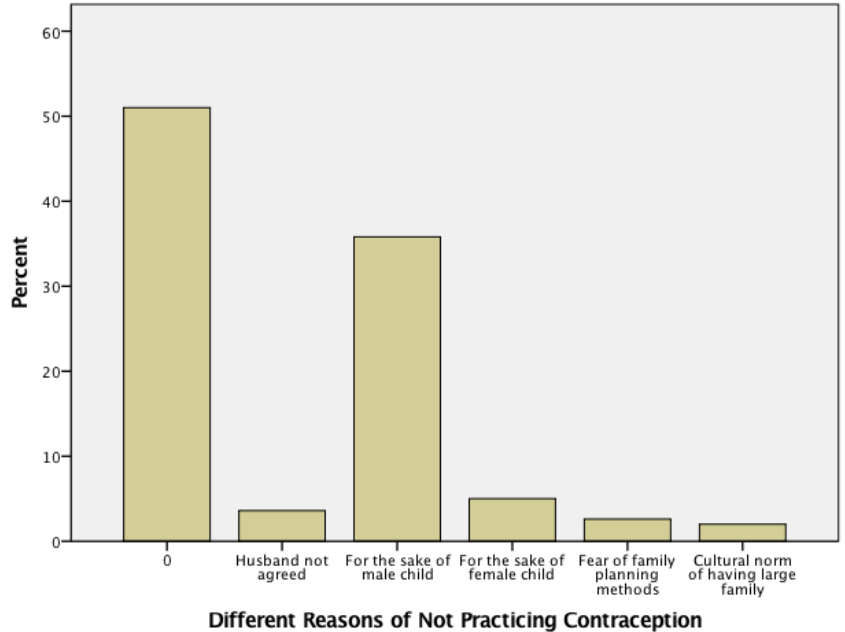
Figure 3. Reasons listed by respondents of not using any sort of contraception (Abbreviation 0 stands for contraceptive users). Table 2. Association between women of low parity and high parity with respect to fetal complica- tions (application of Chi-Square test keeping the level of significance ≤ 0.05 ).